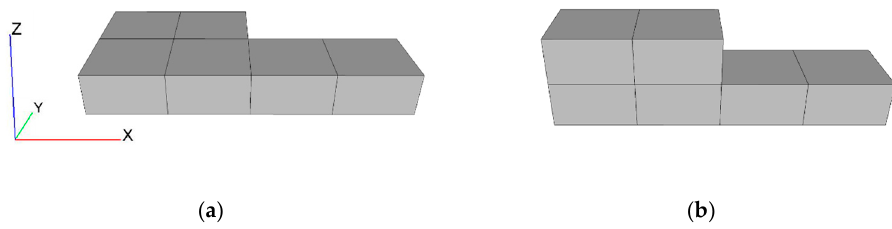
Figure 9. Rotation around axis X is applied between a one-story batch ( a ) and a two-story batch ( b